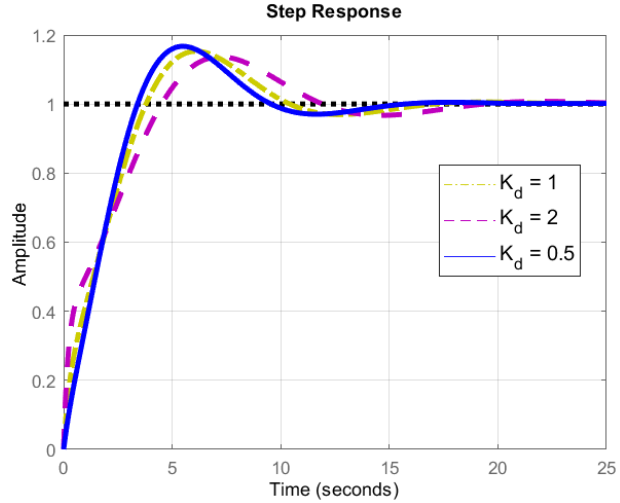
Figure 10. Principle of Derivative